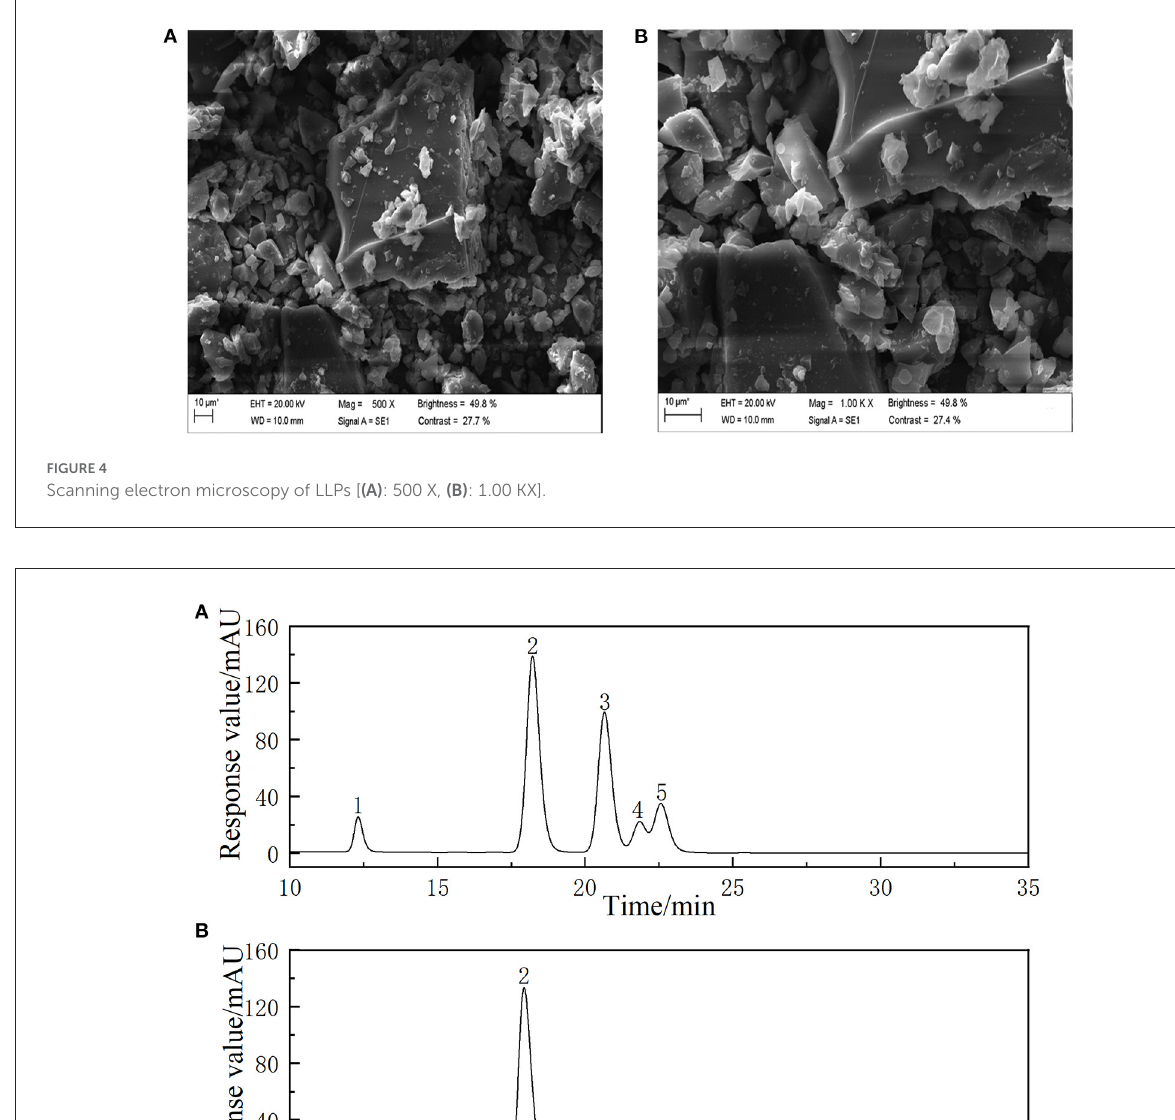
at 0.2 mg/mL, increased slowly in the range of